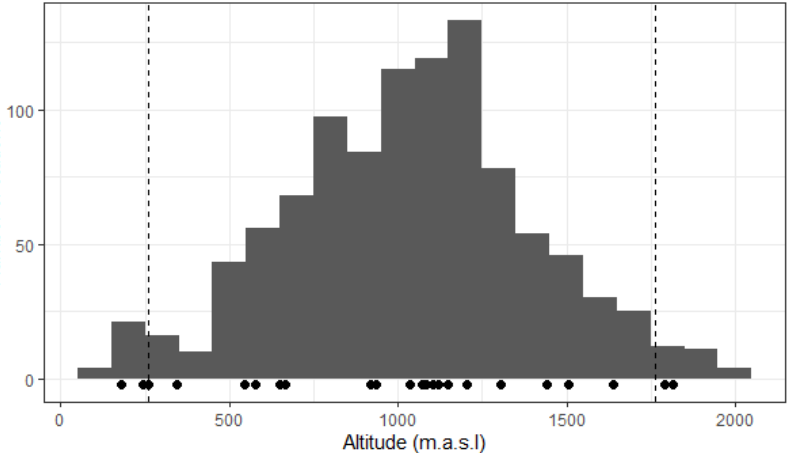
Figure 2. Altitudinal distribution of all known French locations of Lilium pomponium . Binwidth is 100 m. Dashed lines represent quantiles at the 2.5% and 97.5% levels: 95.0% of stations are between 260 and 1762 m. Black dots under the histogram correspond to the locations of the 23 sampled populations.